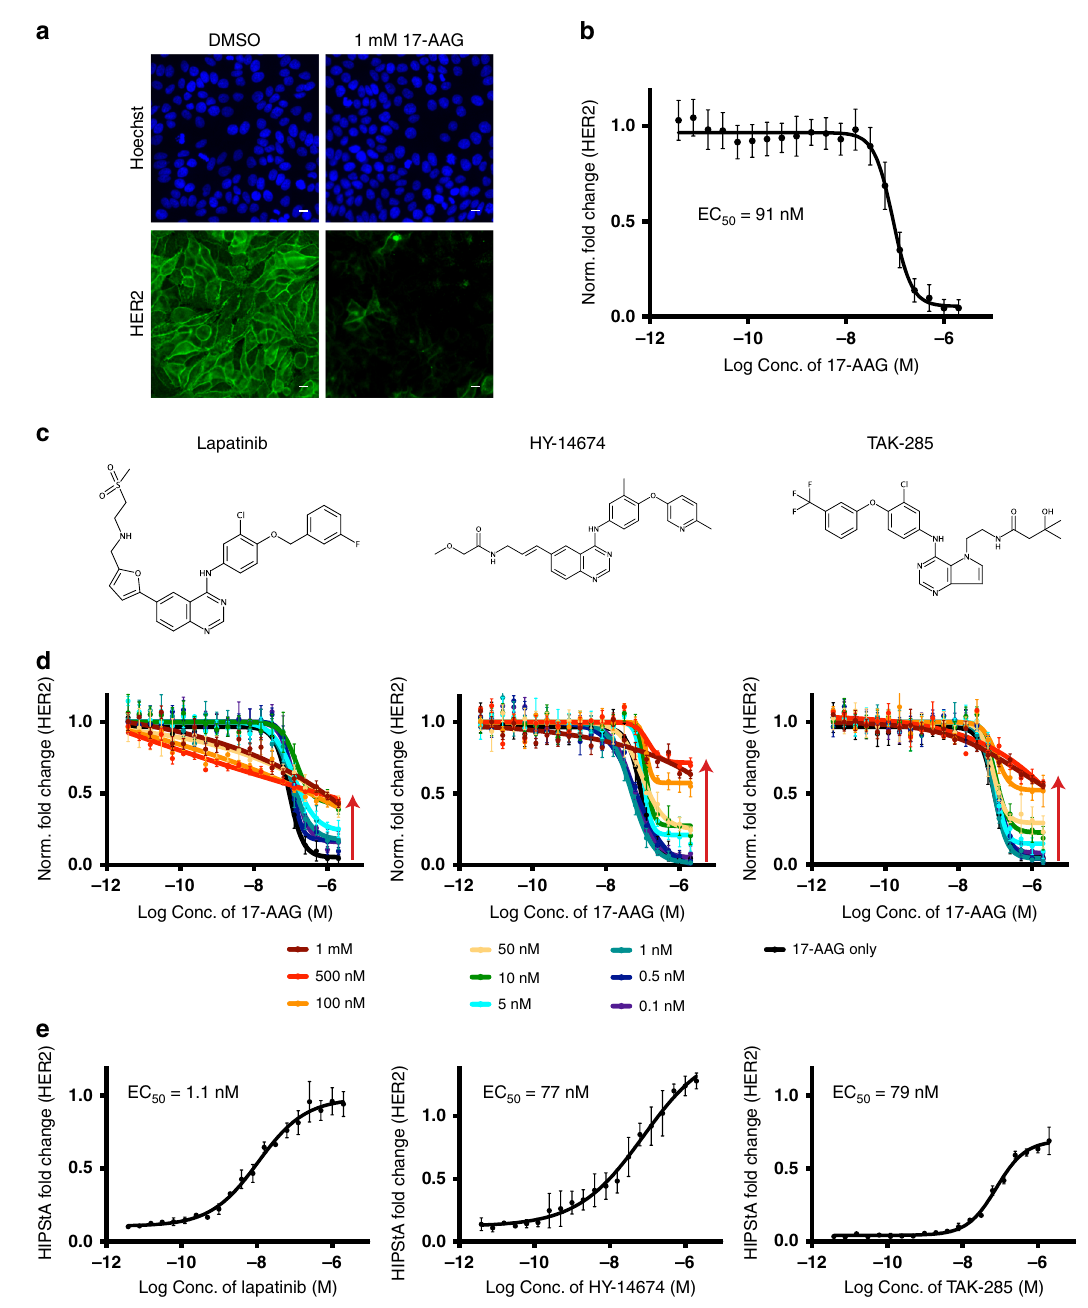
Fig. 3 Quantitative fl uorescence imaging measuring the effect of 17-AAG on HER2. a Immuno fl uorescence images of HER2 protein in MCF-7 neoHER2 cells treated with DMSO or 17-AAG (1 µ M) for 4 h. The upper panels show Hoechst 33342 staining of the DNA (blue) indicating the nuclear region, while the lower panels show the HER2 immuno fl uorescence stain. Scale bar − 20 μ m. b The change in mean HER2 protein per cell (MCF-7 neoHER2) was calculated for a range of concentrations of 17-AAG and expressed relative to the HER2 level in DMSO treated samples and the no primary antibody control sample. c Chemical structures of HER2 inhibitors: Lapatinib, HY-14674, and TAK-285. d Measurement of the relative HER2 protein levels in MCF-7 neoHER2 cells pre-treated with a range of concentrations of HER2 inhibitors (indicated by color) then treated with a titration of 17-AAG (x-axis) for 4 h. HER2 levels are expressed as normalized fold change in HER2 levels relative to the DMSO treated sample (Norm. Fold Change). e Measurement of the relative HER2 protein levels in MCF-7 neoHER2 cells pre-treated with a titration of each HER2 inhibitor then treated with 2 µ M 17-AAG. HER2 protein levels are expressed as the fraction of HER2 present in the co-treatment condition relative to the corresponding concentration of inhibitor only (HIPStA Fold Change). The relative EC 50 values were calculated using a four parameter quadratic curve fi t in PRISM. Error bars represent standard error of mean ( n = 3). Source data are provided as a Source Data fi